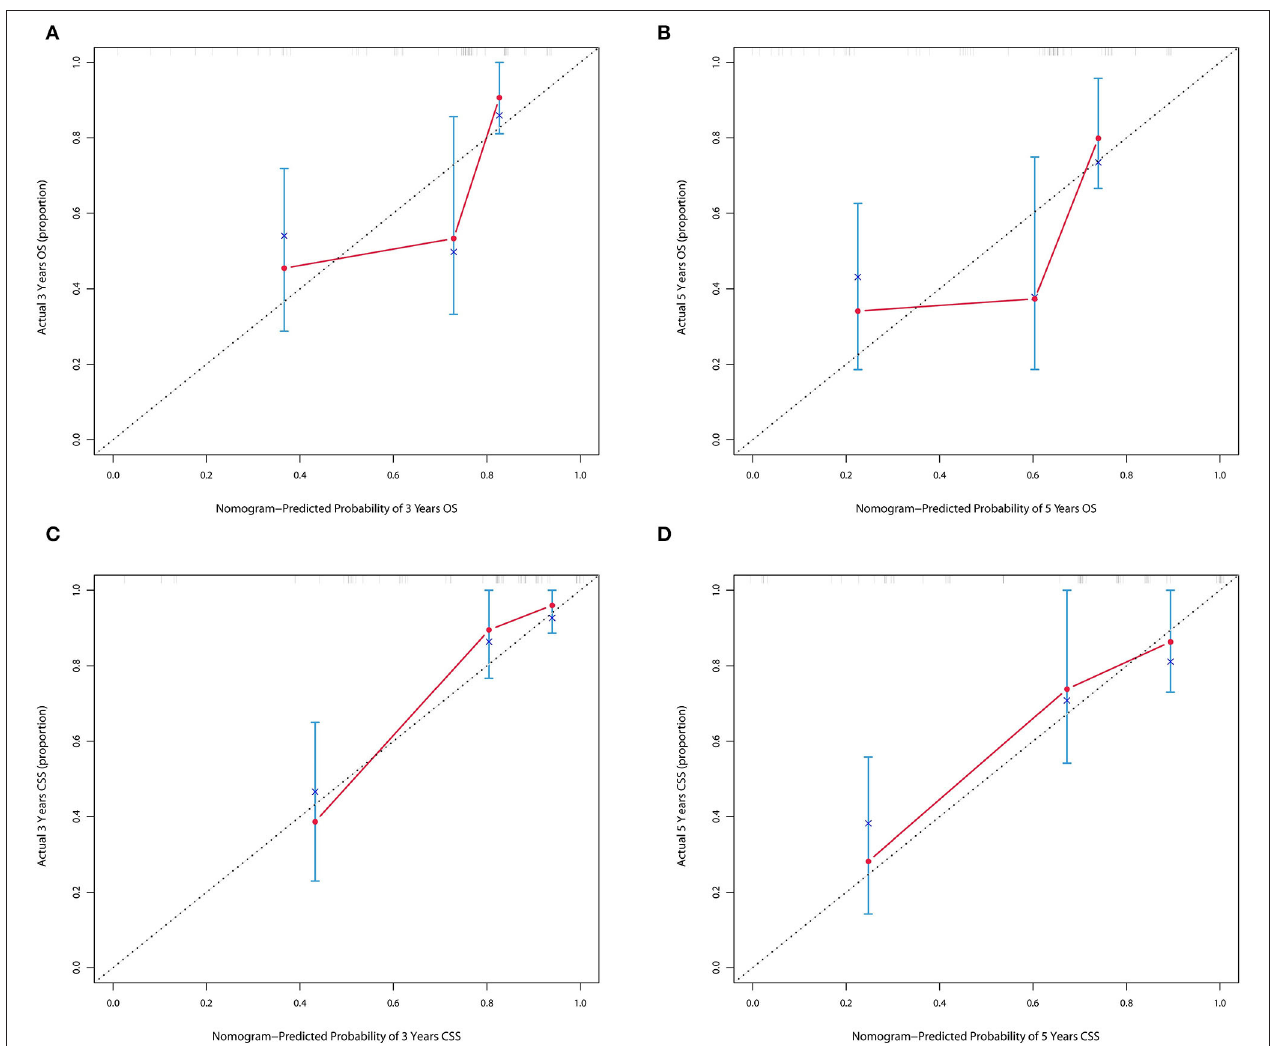
FIGURE 6 | (A,B) Calibration plot of nomograms in 3- and 5-years in the validation cohort for OS. (C,D) Calibration plot of nomograms in 3- and 5-years in the validation cohort for